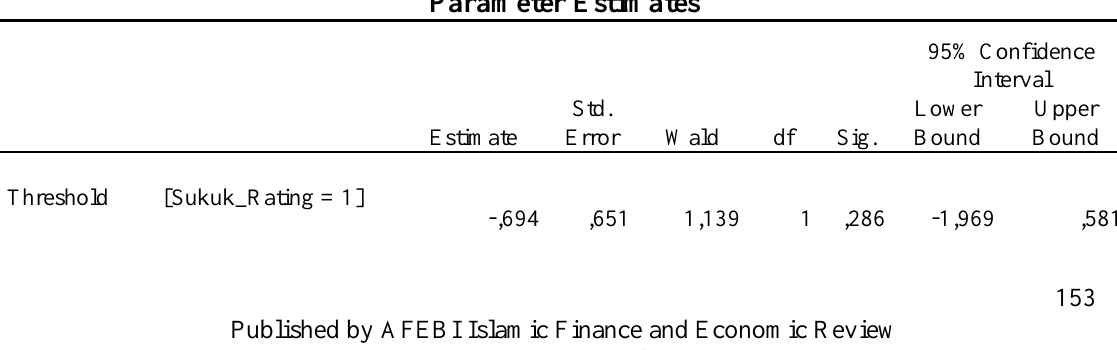
Table 4. Results of Estimated Parameters of Ordinal Logistics Regression